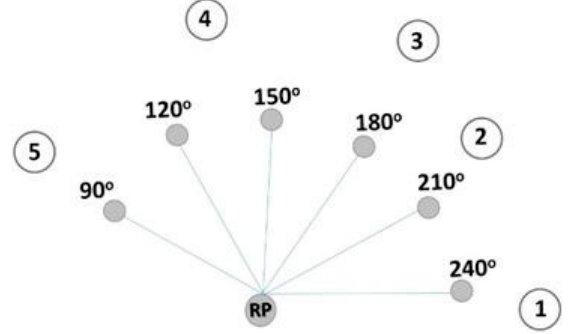
Figure 2. Scheme of the spectro-radiometric measurements (six angles from a reference point “RP”) and soil respiration collars distribution (5 circles) in the cultivated plots.